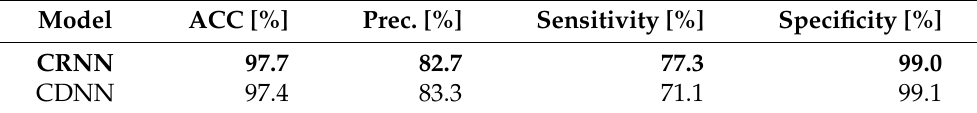
Table 8. Results of the best recursive and combining model on the test set. The models were trained on a set of all 5 validation subsets. The ratio of the number of intestinal sound frames to the total number of frames in the test set is 15%.